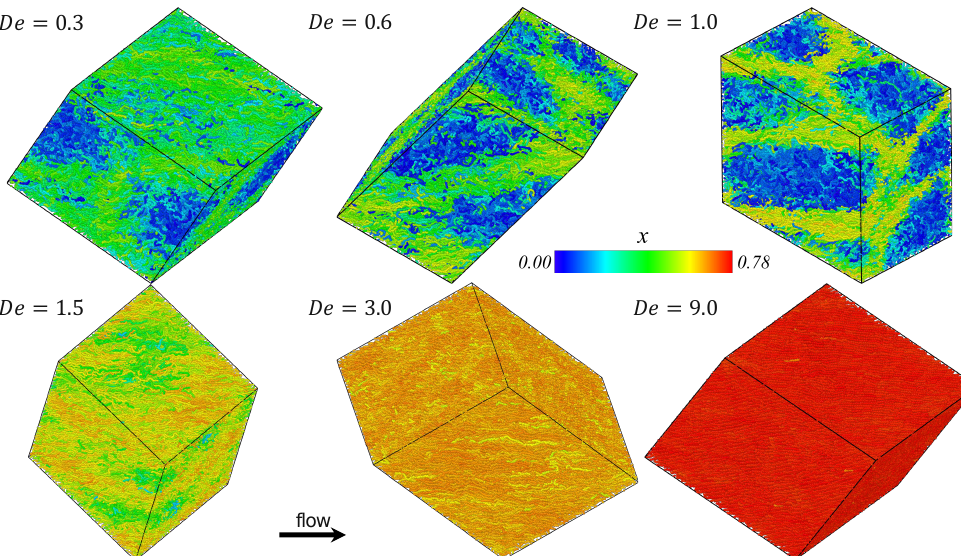
Figure 4. Snapshots of steady-state UEF of the PE melt at various values of De . Cooler colors denote relatively coiled molecules whereas warmer colors signify more highly stretched molecules. The black arrow denotes the direction of flow for all